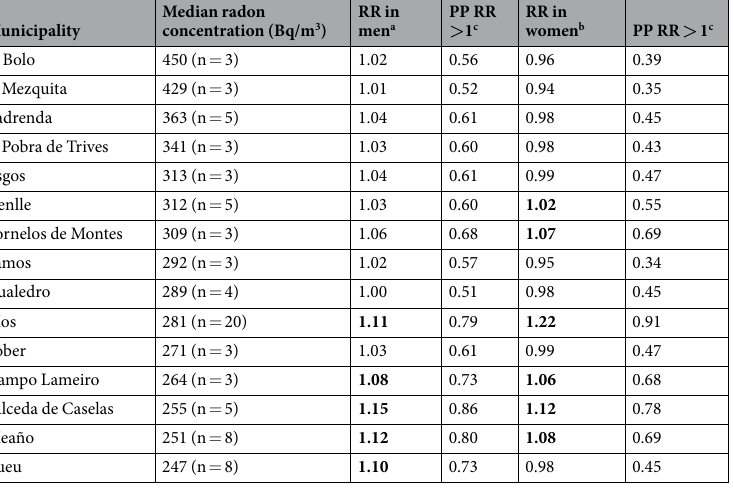
Table 2. Municipalities with the ranked by residential radon concentration and relative risk for brain cancer in males and females. a In bold those municipalities with relative risk of brain cancer above percentile 75 (1.07). b In bold those municipalities with relative risk of brain cancer above percentile 75 (1.02). c Posterior probability that RR >